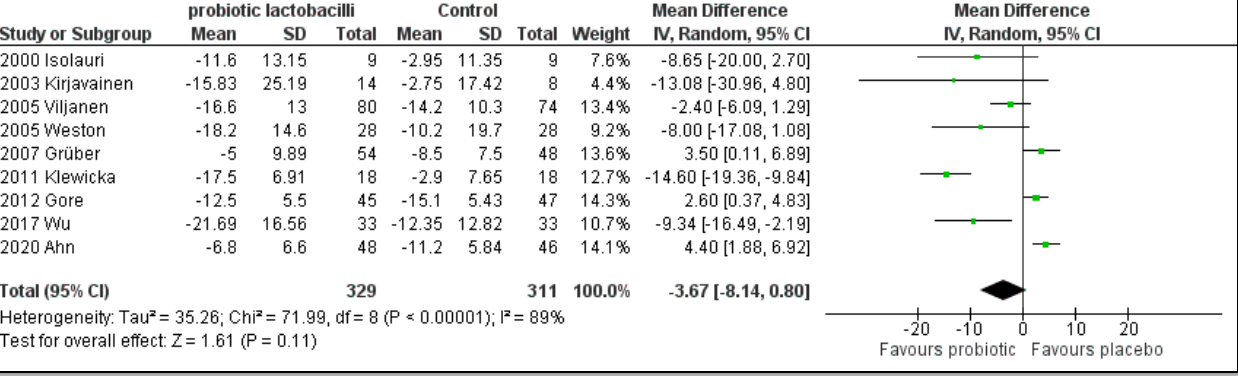
Figure 8. Subgroup meta-analyses of the e ff ect of single-strain probiotic lactobacilli compared to placebo on the SCORAD index change in children up to 4 years of age [41–44,47,49,50,54,55].